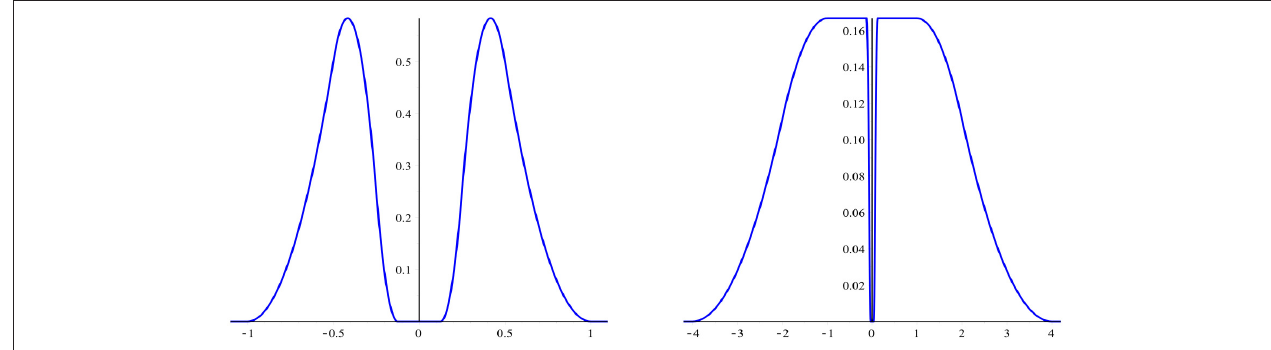
FIGURE 1 | Plots of the splines